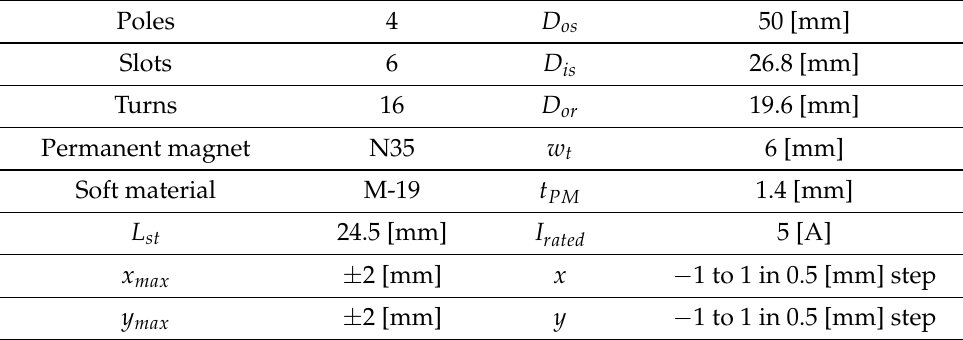
Table 3. FE analysis conditions and self-bearing machine. Poles